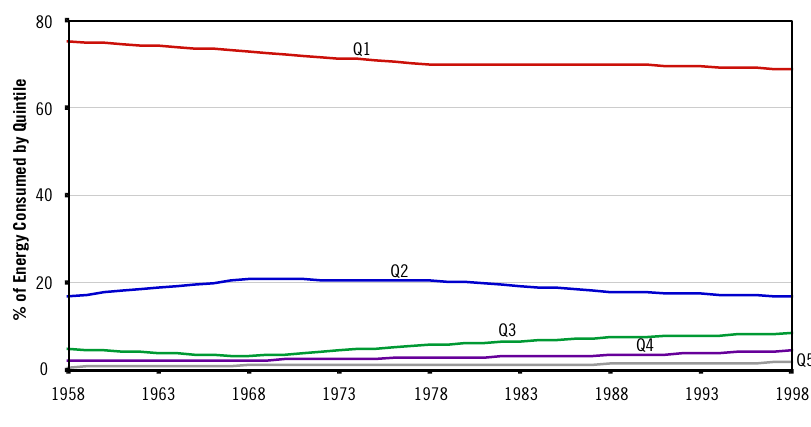
Figure 7 – World Commercial Energy Consumption by